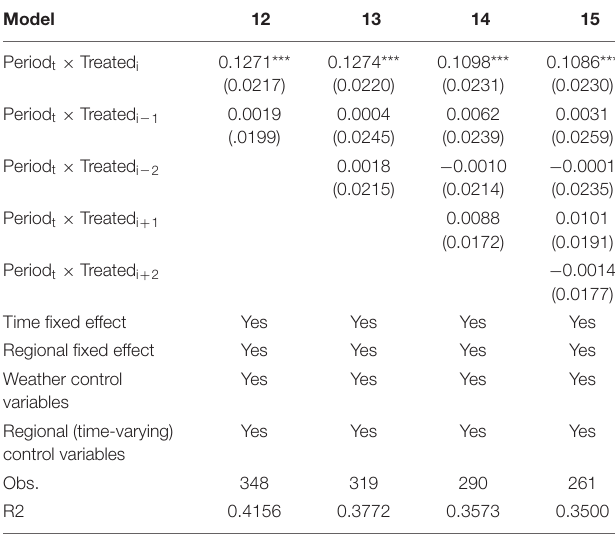
TABLE 5 | Expectation and lag effect test of policy